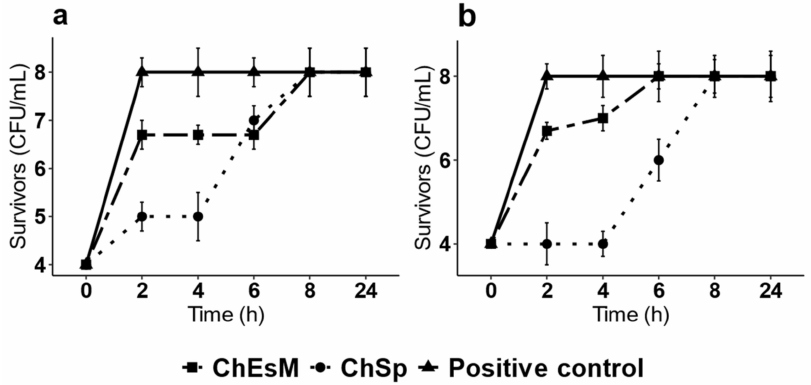
Figure 4. Effect of ChSp and ChEsM on the survival of S. aureus ( a ) and E. coli ( b